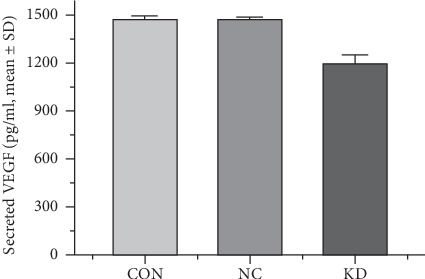
Quantitation of secreted VEGF by ELISA. VEGF secretion from control (CON), negative control (NC), and caveolin-1 siRNA-LV (KD) groups was (1465 ± 26.21), (1466 ± 17.62), and (1193 ± 50.24) pg/ml, respectively (KD versus CON, P=0.011; KD versus NC, P=0.010).